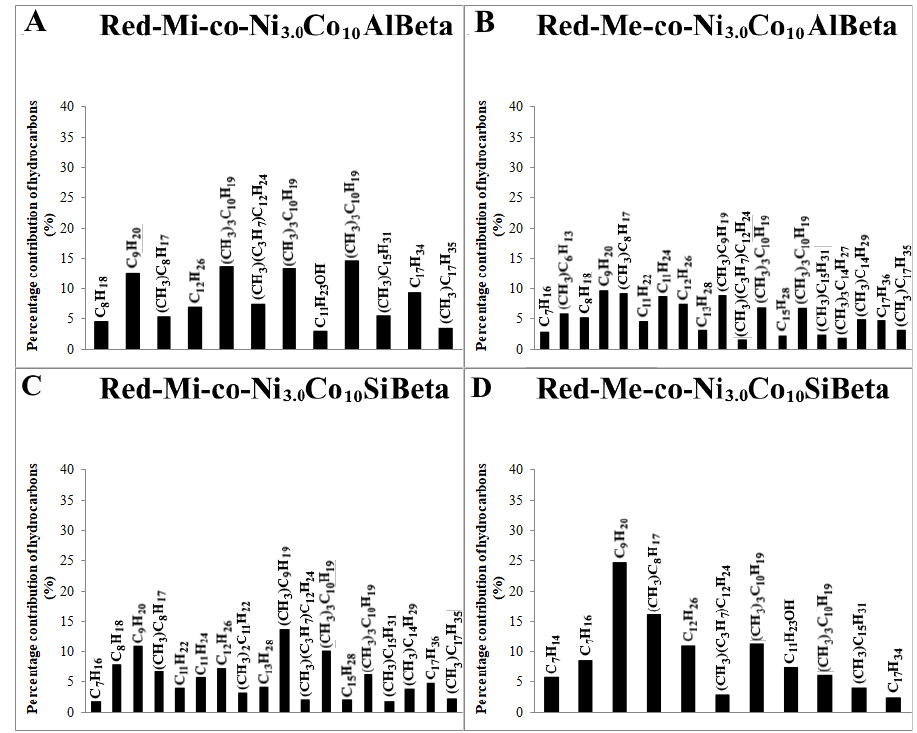
Figure 11. GC-MS analysis of liquid products achieved in FTS over ( A ) Red-Mi-co-Ni 3.0 Co 10 AlBeta, ( B ) Red-Me-co-Ni 3.0 Co 10 AlBeta, ( C ) Red-Mi-co-Ni 3.0 Co 10 SiBeta, ( D ) Red-Me-co-Ni 3.0 Co 10 SiBeta.